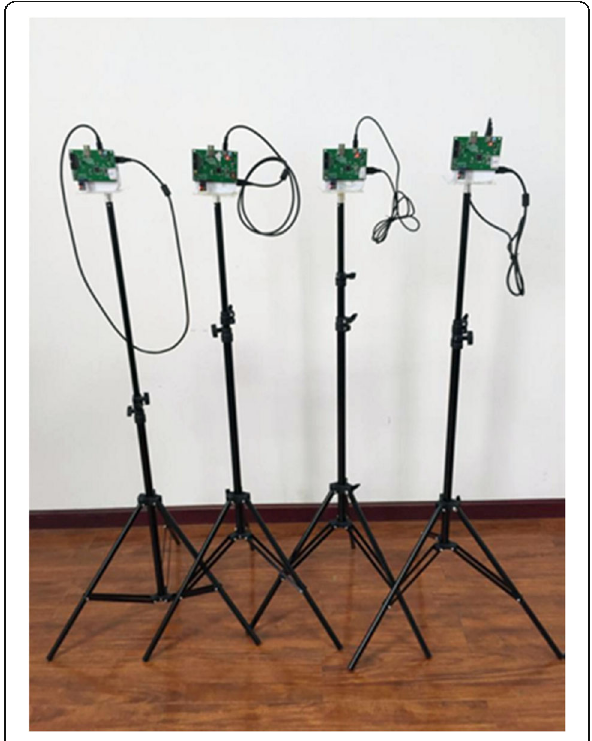
Fig. 7 Base stations. The base stations adopt the STM32103RC chip as the control unit, and each base station has an extra Wi-Fi module called ESP8266, which is used to connect with the